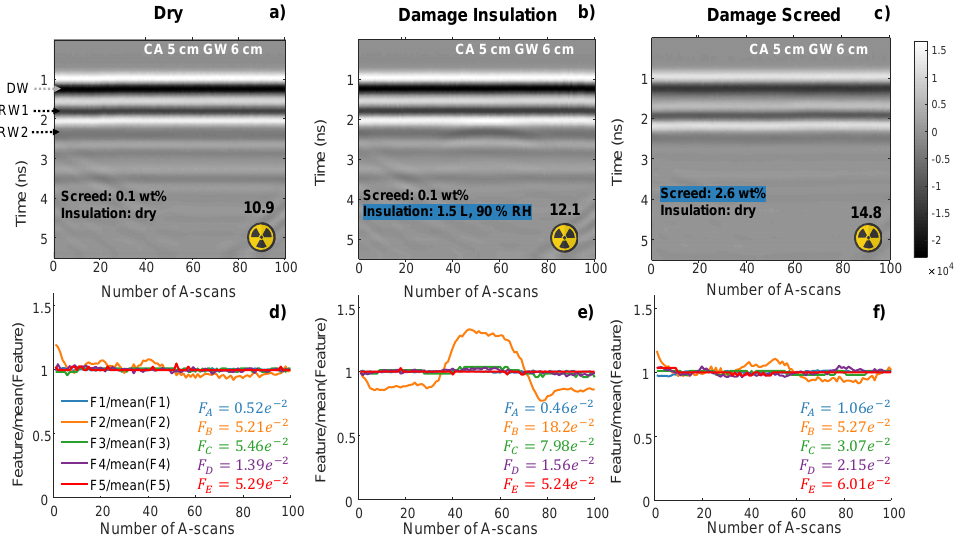
Figure 10. Measurements at an 7 cm CA and 6 cm GW floor construction for the scenarios: ( a ) dry, ( b ) damage insulation and ( c ) damage screed. The bottom ( d – f ) shows the respective A-scan vector plots for each B-scan